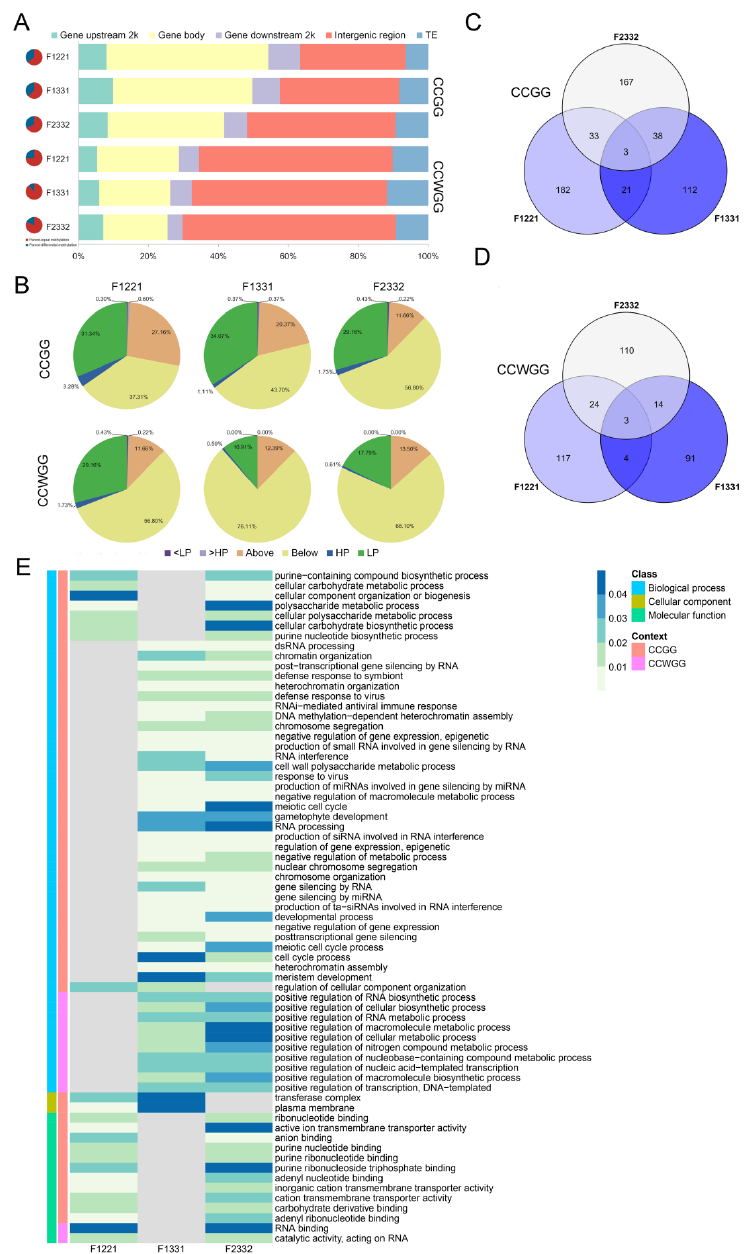
Figure 4. Non-additively methylated sites in reciprocal hybrid seeds. ( A ) The proportion of reciprocal non-additive methylated sites (re-DMSs) in whole genome and parent methylated region. The left pie chart shows the ratio of these sites in parent methylated region, red color denotes parent-equal regions and blue color symbolizes parent-unequal regions. The right chart displays the scale of these sites in genomic element. ( B ) Non-additive categories of re-DMSs in three group reciprocal hybrids. Re-DMSs were classified when methylation change in both reciprocal hybrids is identical (e.g., both “<LP” in F12 and F21). “Above” or “Below” means methylation level of reciprocal hybrids is greater than two parents or less than two parents of parental equivalent regions. In parental unequal regions, “HP” or “LP” means methylation level of reciprocal hybrids is similar to highest or lowest methylation level, “<LP” or “>HP” means methylation level of reciprocal hybrids is lower than in lowest parent or higher than in highest parent. ( C , D ) Statistics of re-DMSs in three reciprocal hybrids for two methylation contexts. ( E ) Enriched GO processes of non-additively methylated genes for three reciprocal hybrids. The color is bluer as p value is more insignificant, grey means insignificant